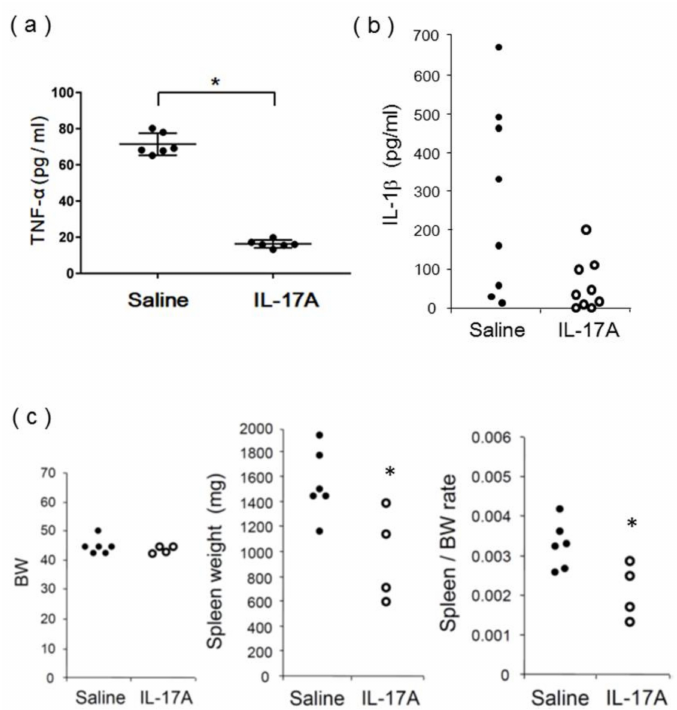
Figure 6. Serum cytokines and spleen weight in vaccinated MRL / lpr mice; ( a ) Serum TNF- α concentration was significantly decreased in IL-17A vaccine group; * p < 0.05 vs. saline group; n = 5. ( b ) Serum IL-1 β concentration was significantly decreased in IL-17A vaccine group; * p < 0.05 vs. saline group; n = 8 and 9, respectively. ( c ) Spleen / body weight ratio was significantly decreased in vaccine group; * p < 0.05 vs. saline group; n = 6 and 4,